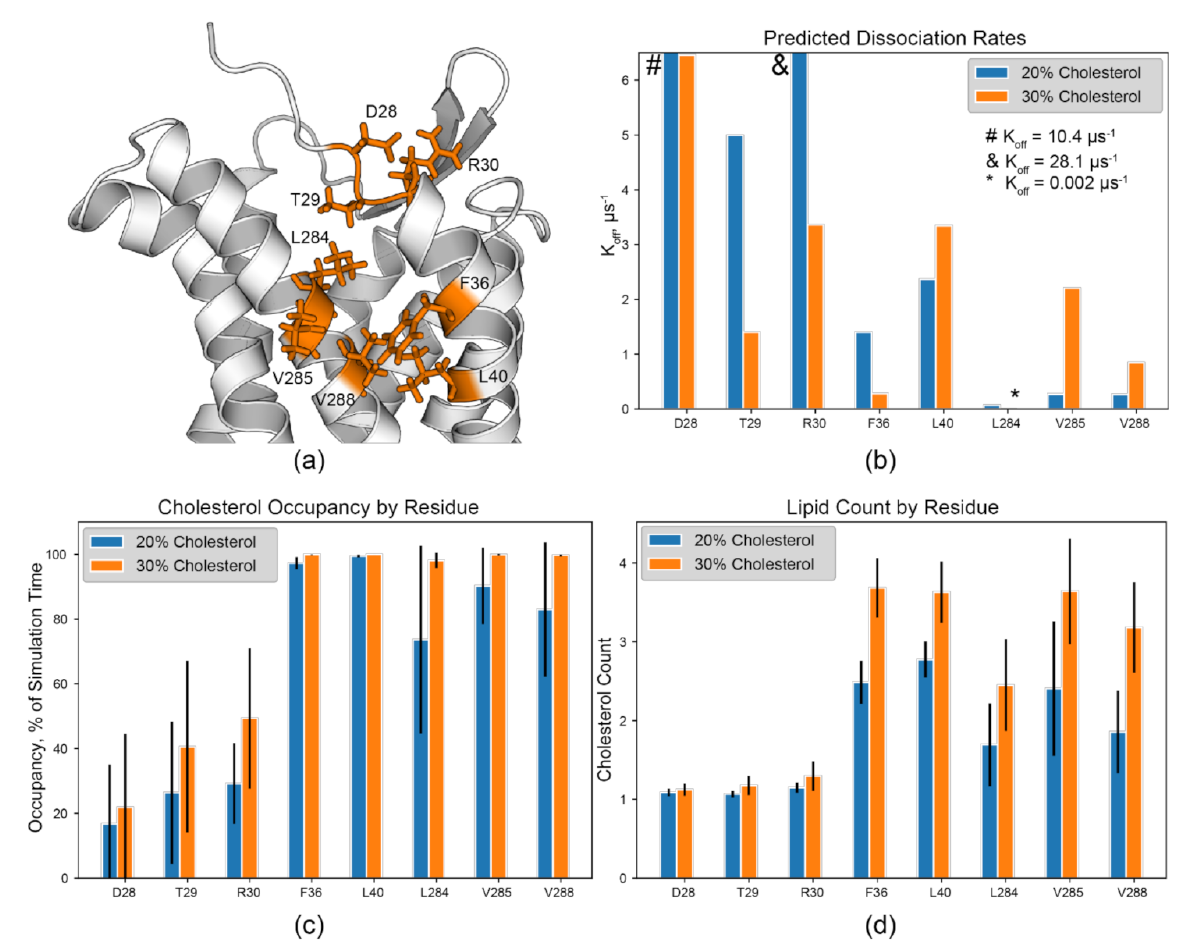
Figure 5. The TM1/7 site as a potential CCR3 cholesterol binding site. ( a ) CARC and CARC-adjacent residues identified in the TM1/7 binding site, color coded as in Figure 4. R30 1.28 –F36 1.34 –L40 1.38 form the CARC motif in this binding site. ( b ) Predicted K off values, ( c ) lipid occupancy as a percent of simulation time, and ( d ) lipid count from the 20% and 30% cholesterol simulations. Error bars indicate the standard deviation between replicates. Symbols (#, &, and *) denote values outside of the plot